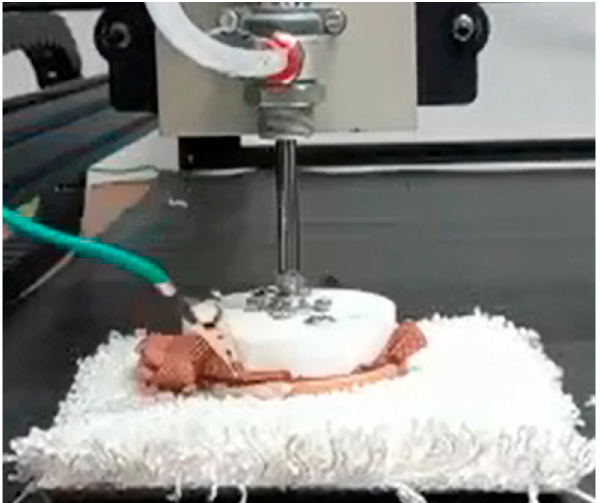
Figure 4. Compressible floorcovering sample to see the effect of variable pressure.